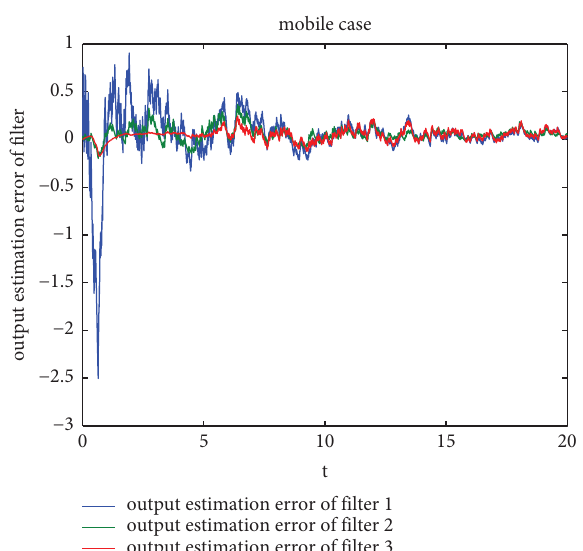
Figure 7: Output estimation errors of